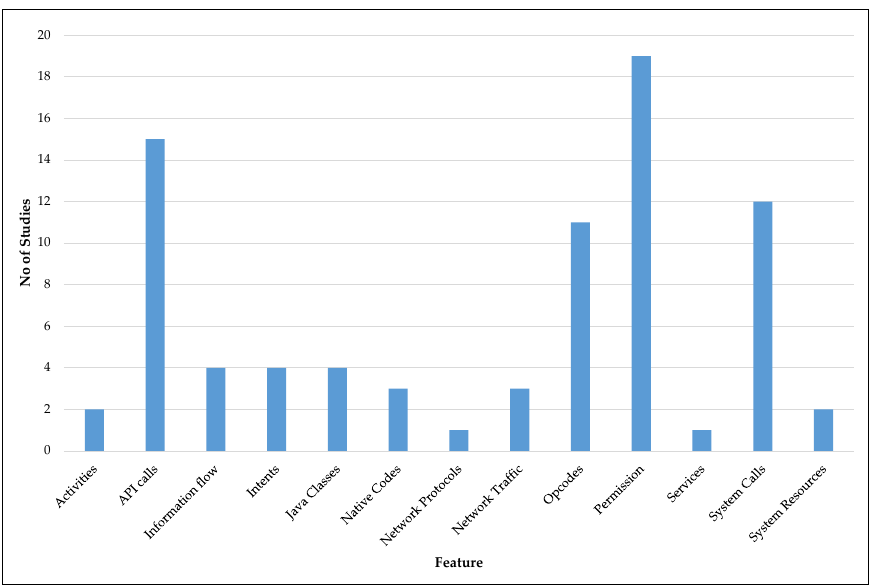
Figure 5. Extracted features in the reviewed